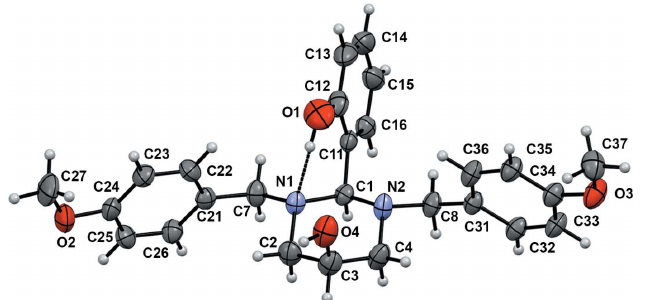
Figure 1 The molecular structure of the title compound. Displacement ellipsoids are drawn at the 50% probability level. The intramolecular hydrogen bond is shown as a dashed line and, for clarity, only the major disorder components are included.